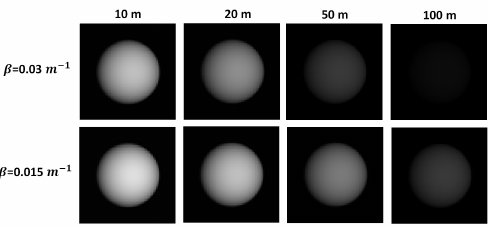
Figure 6. Simulationof image contrast attenuation or degradation using Matlab, due to the presence of fog with two different scattering coefficients (absorption was set to zero), shown as a function of the light propagation